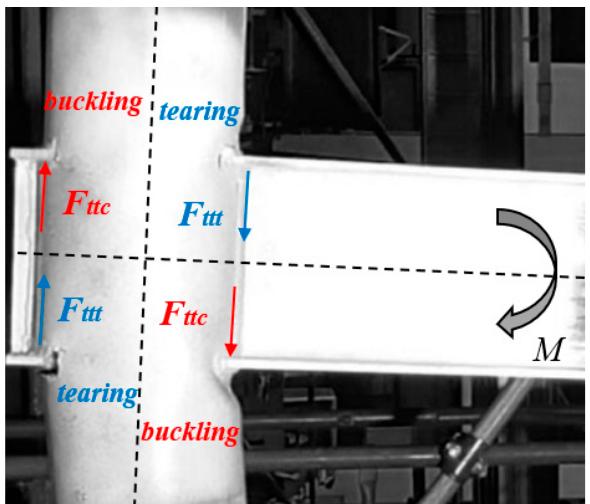
Figure 3. Actions applied to the components tt t/ tt c induced by the rigid rotation of the beam.